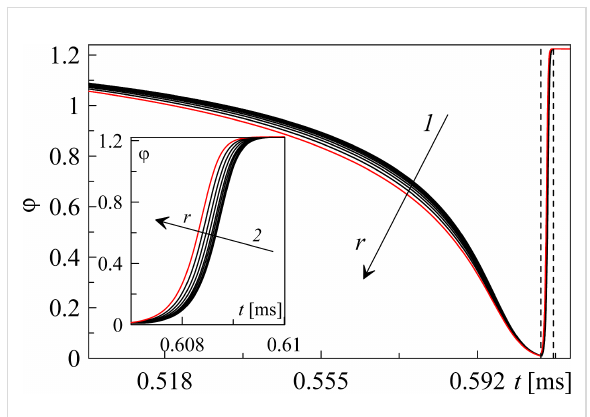
Figure 3: (a) Time dependence of the order parameter φ ( t ), calculated using the same parameters as in Figure 2 and corresponding to the melting process (arrow 1) before the first dashed line and to the recrys- tallization process (arrow 2) after the first dashed line for different values of the radial coordinate r . Arrows show the increment of a radial coordinate r from 2 to 18 μ m, with a step of 2 μ m. Inset shows the time interval between two dashed